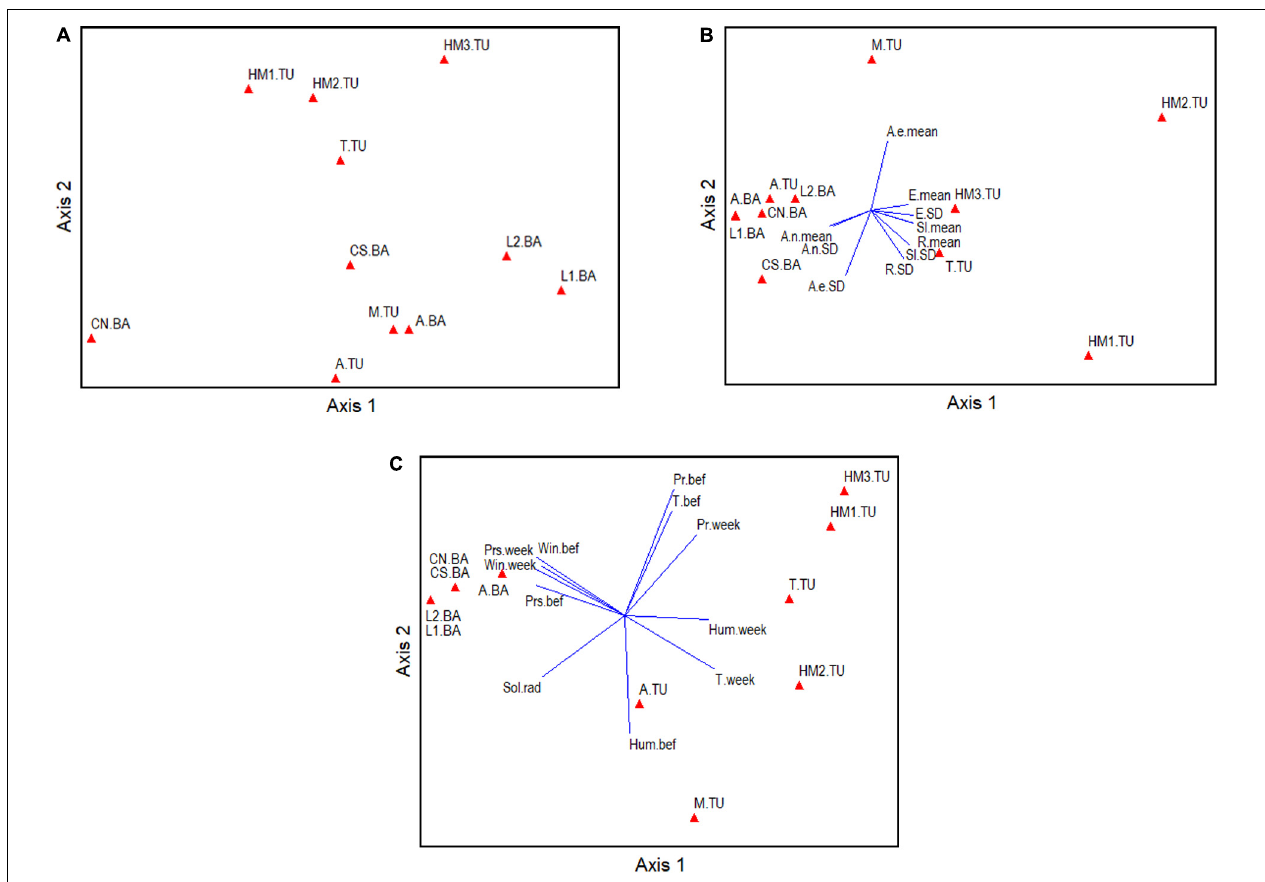
FIGURE 4 | Principal Components Analyses of the Drone Congregation Areas located in two eco-regions in Argentina. PCAs on (A) landscape variables, (B) topographic variables, and (C) climate variables using a correlation matrix in all cases ( Supplementary Table 1 for